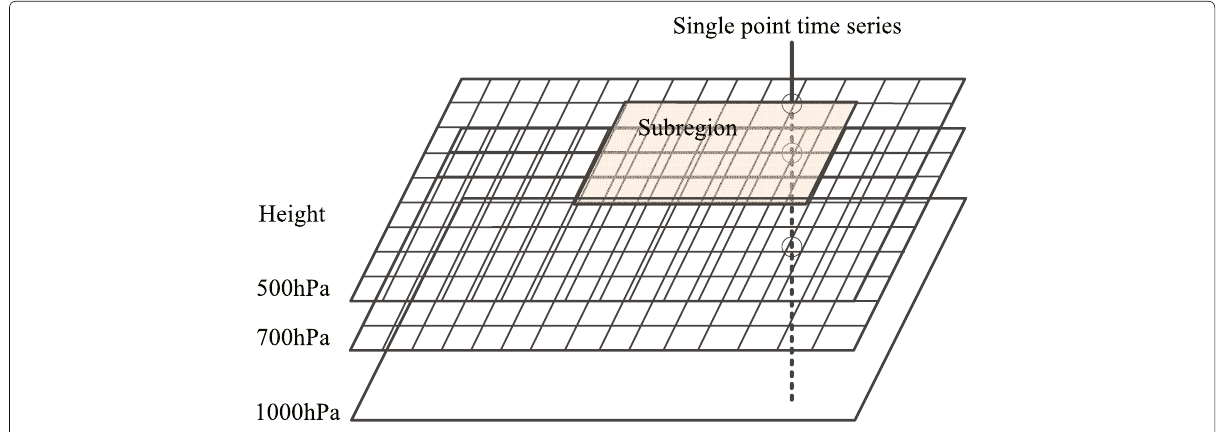
Fig. 2 The structure of multidimensional meteorological